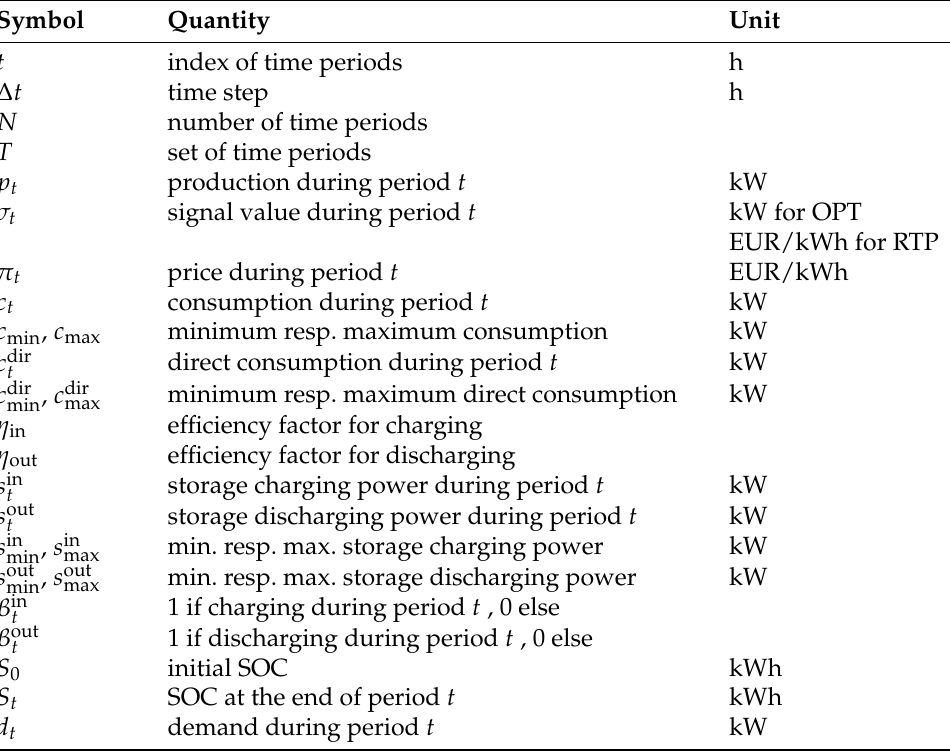
Table 1. Symbols and units used for the energy system